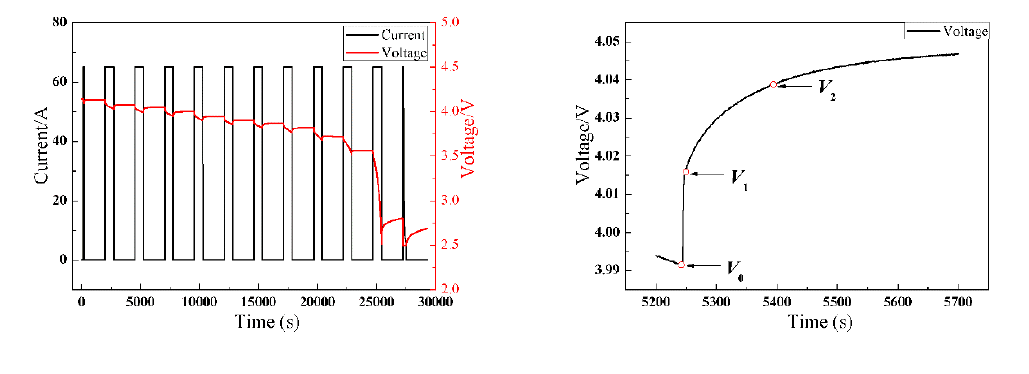
Figure 2 . OCV-SOC relationship. Figure 2. OCV-SOC relationship.